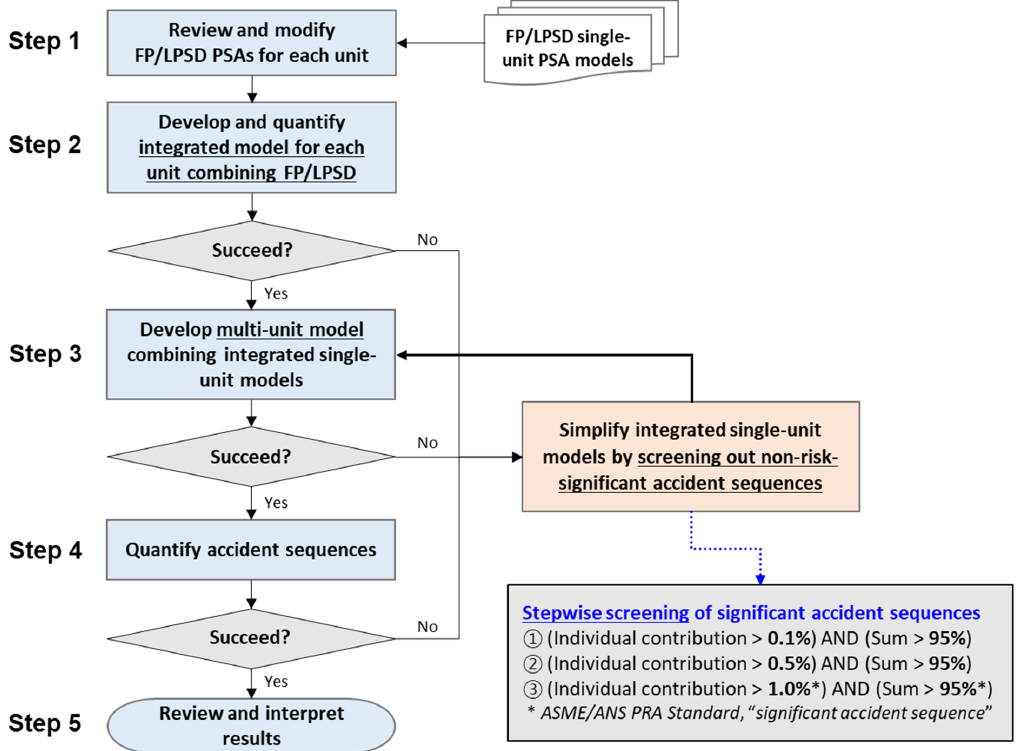
Figure 2. Procedure of MUPSA considering POS combinations.